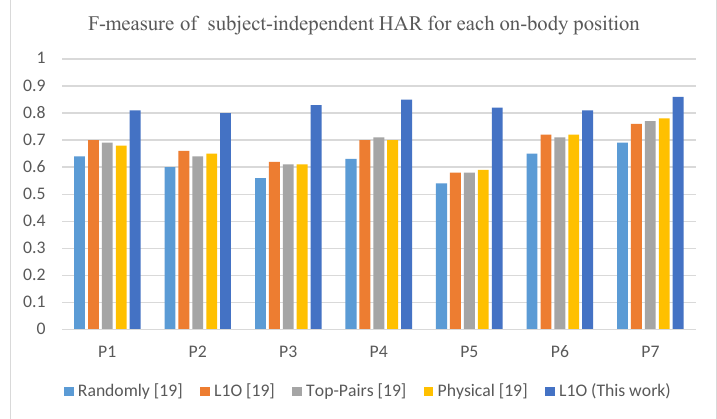
Figure 8. F-measure of position-dependent and subject-independent HAR for this work using L1O compared to the work in [19] with different evaluation